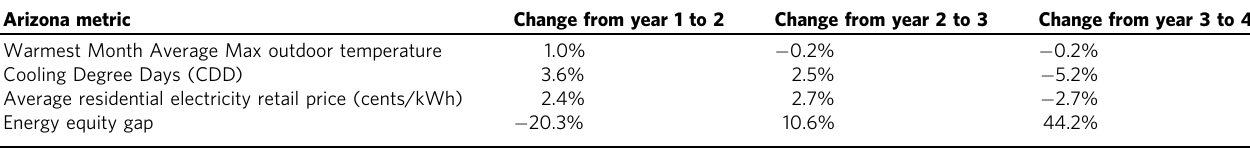
Table 1 Temperature, electricity price, and energy equity gap shifts in Arizona.